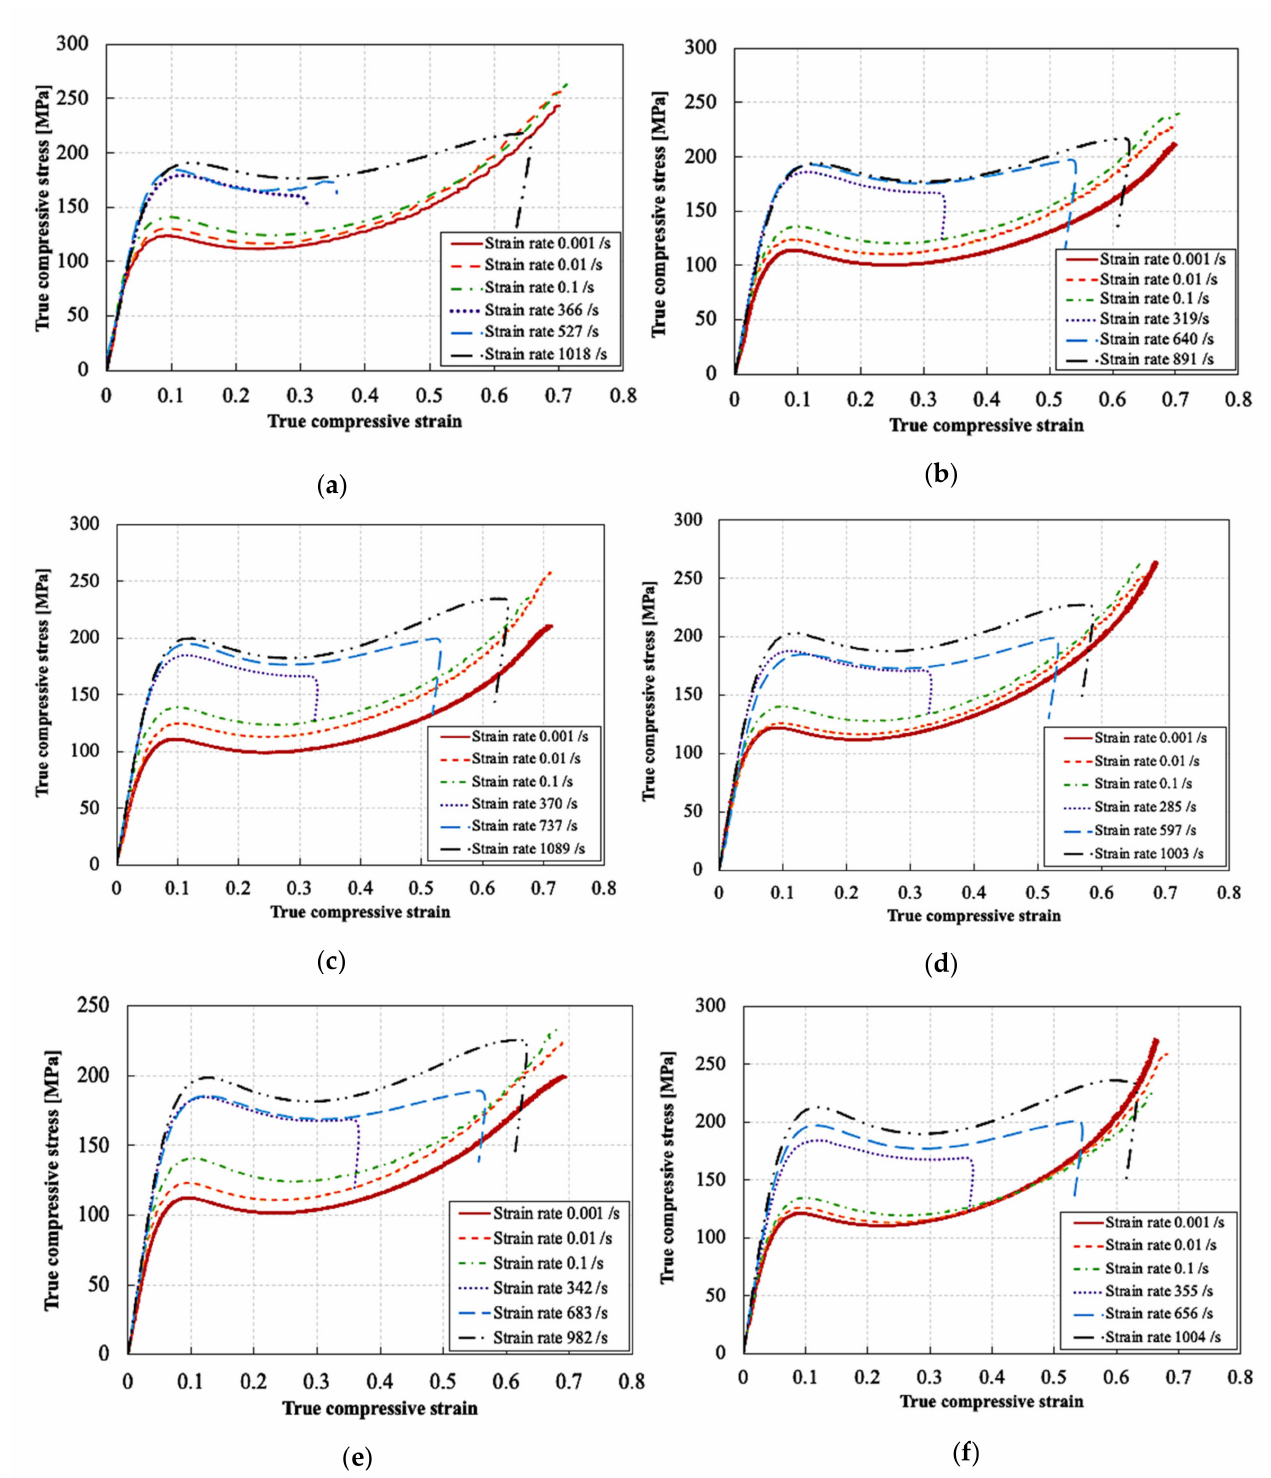
Figure 7. Representative compressive true stress-true strain curves at different strain rates for the RTM6 epoxy/silica nanocomposites: ( a ) unfilled neat resin, ( b ) non-functionalized 0.1%, ( c ) non-functionalized 1%, ( d ) non-functionalized 5%, ( e ) functionalized 0.1% and ( f ) functionalized